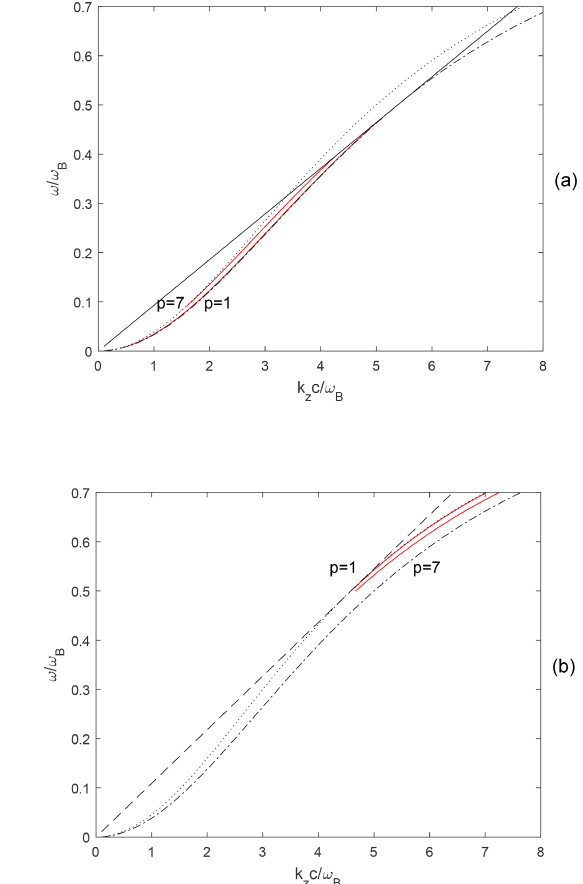
Figure 2. Relationship between the frequency and the longitudinal component of the wave vector for the first ( p = 1) and seventh ( p = 7) ducted modes at (ω p , out /ω B ) 2 = 25 are shown in red: (a) in the enhanced duct with (ω p , int /ω B ) 2 = 29 and (b) in the depleted duct with (ω p , int /ω B ) 2 = 21